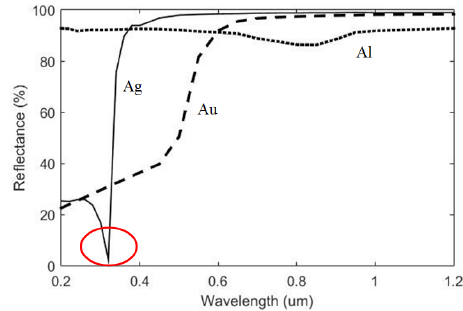
Figure 2. The reflectance of three metals silver (Ag) (solid line), aluminum (Al) (dotted line), and gold (Au) (dashed line) in the UV-VIS-NIR region [13].